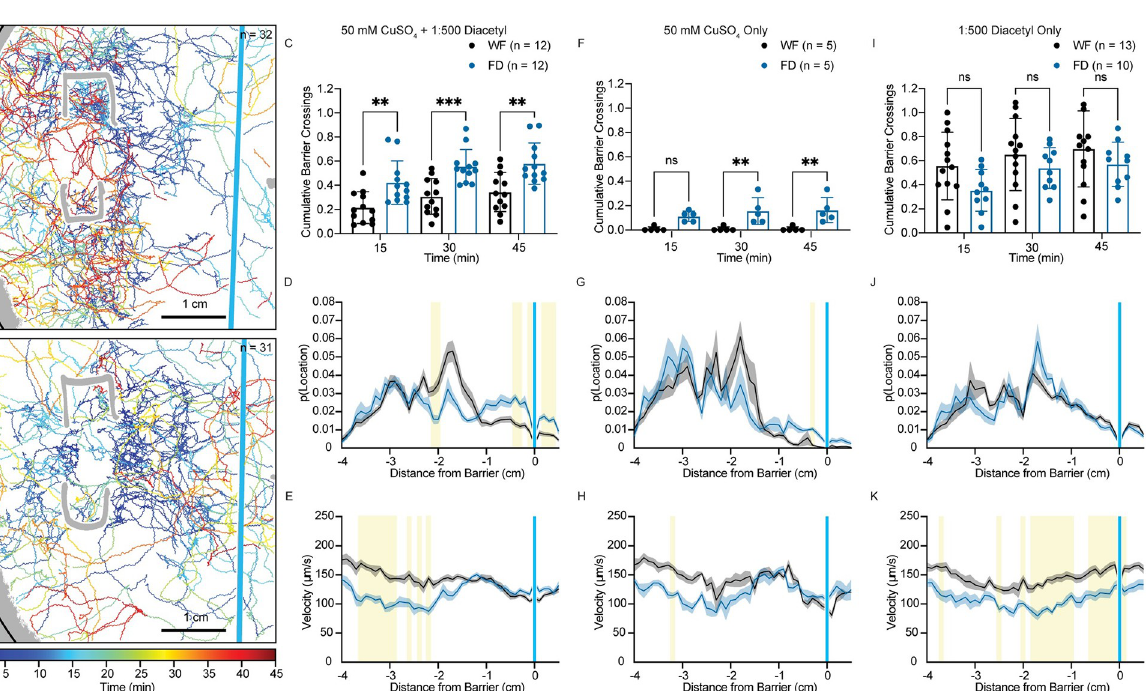
PLOS Genetics | https://doi.org/10.1371/journal.pgen.1010178 May 5,